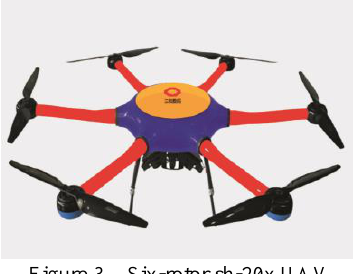
Figure 3 ． Six-rotor sh-20x UAV